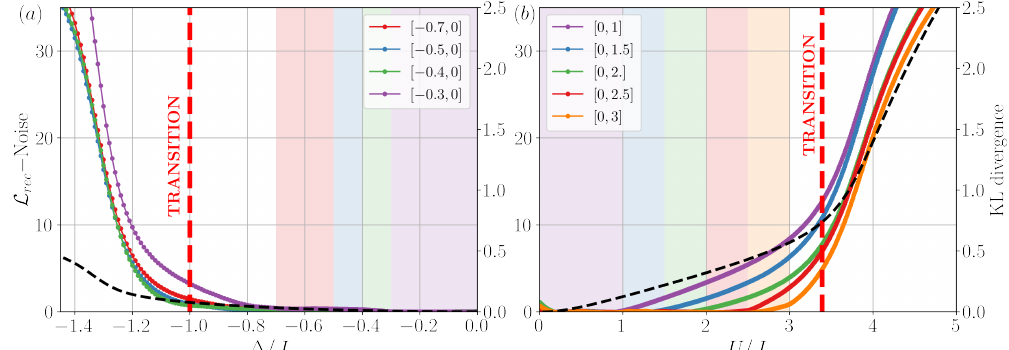
Figure 5: The loss curves for the XXZ with L = 400 sites in ( a ) and for the BH model with L = 256 sites in ( b ) for different training regions indicated in the legend and accordingly to the curves’ color by the shaded regions. The KL divergence is repre- sented with the black dashed line, whose values must be consulted in the rightmost